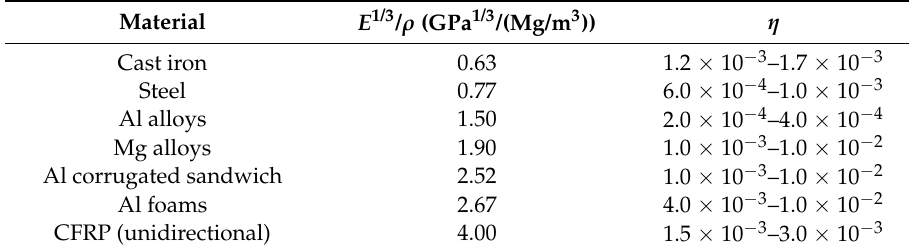
Table 2. Material comparison: structural index versus loss